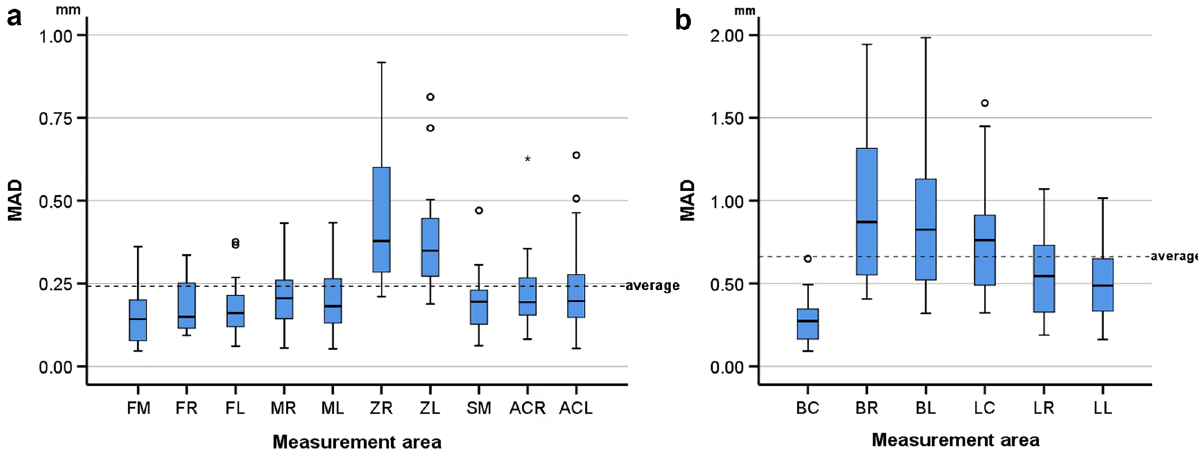
Figure 3. Box plots showing the MAD between the wet and dry models at each measurement area in ( a ) the skulls and ( b ) the mandibles. MAD: mean absolute distance. Skull: forehead middle (FM), right (FR) and left (FL), maxilla right (MR) and left (ML), zygomatic bone right (ZR) and left (ZL), sphenoid bone middle (SM) and anterior cranial base right (ACR) and left (ACL). Mandible: buccal center (BC), right (BR) and left (BL) and lingual center (LC), right (LR) and left (LL). Outliers are shown as black circles (further from the median more than 1.5 times the IQR) or asterisks in more extreme cases (further from the median more than 3 times the